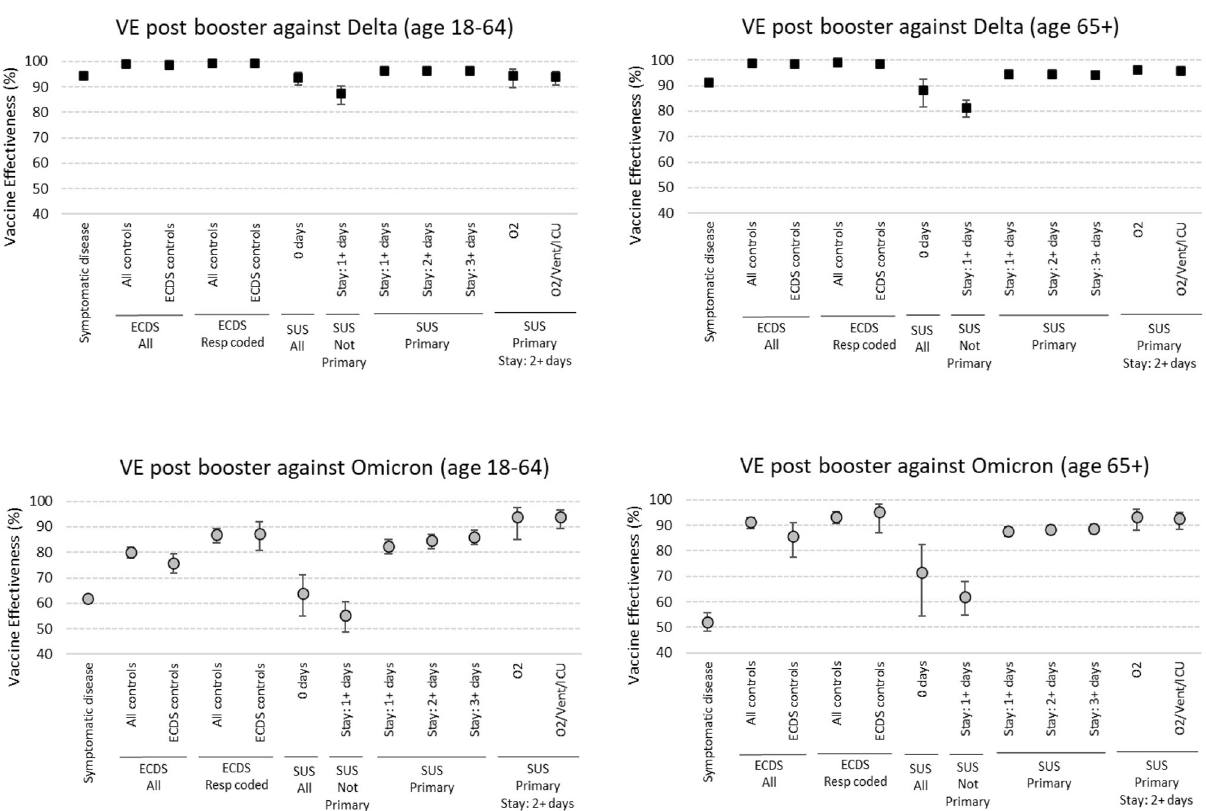
Fig. 1 | Vaccine effectiveness estimates with 95% con fi dence intervals 7+ days after a 3rd dose against symptomatic disease and different hospitalisation outcomes by age group and variant. ECDS Emergency Care Dataset — adminis- trative data from emergency departments, SUS Secondary Users Service — admin- istrative data from all secondary care which is coded on discharge, ECDS All all admissions through emergency care. ECDS Resp Coded respiratory SNOMED coded admissionthroughemergencycare,SUSAlladmittedwitharespiratoryICD code, SUS Not Primary admitted with a respiratory ICD code not in the